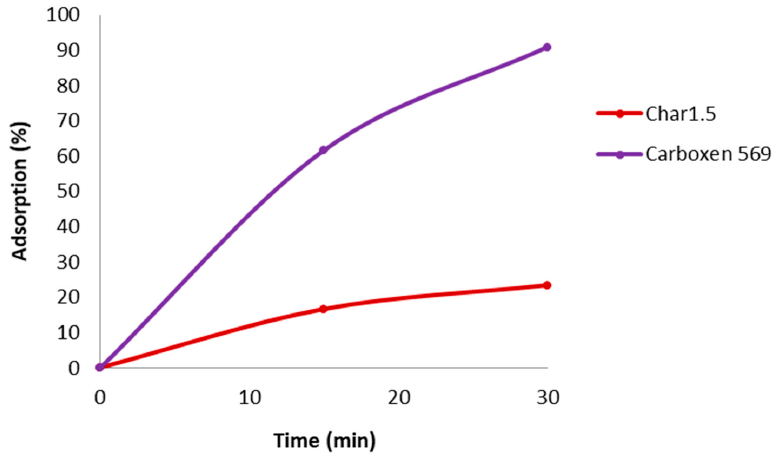
Figure 8. MB adsorption percentage of Char1.5 and Carboxen